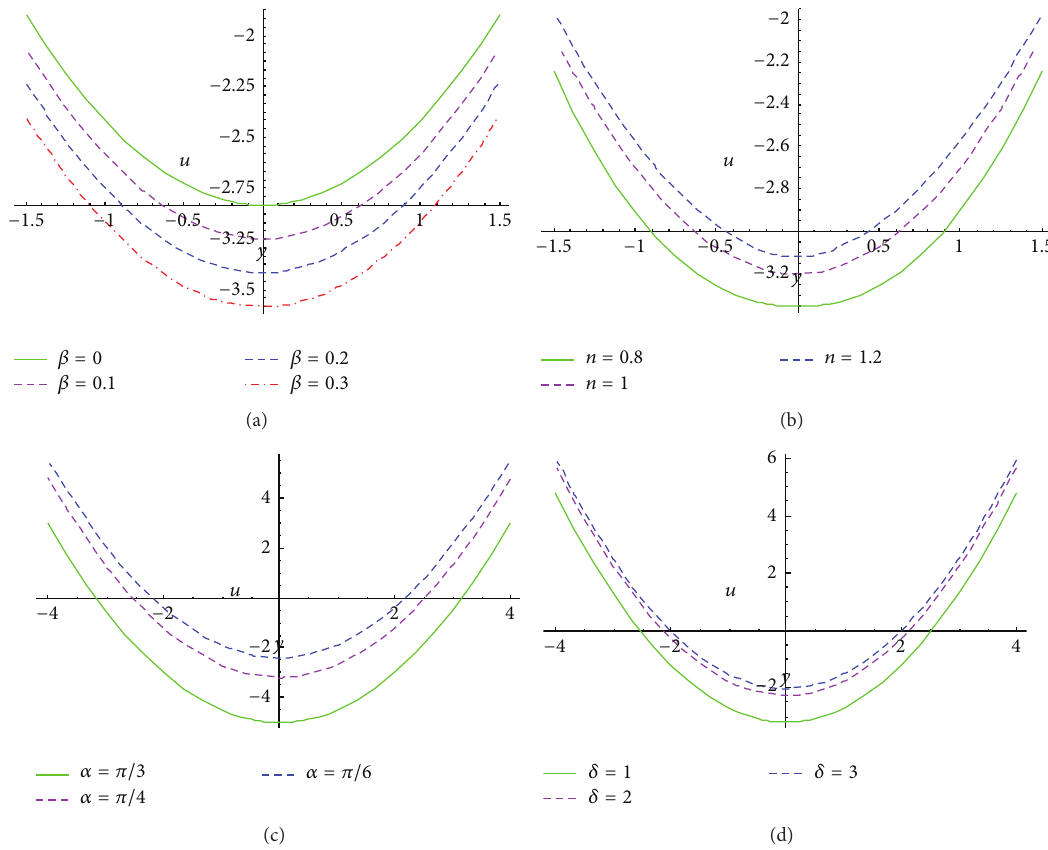
Figure 2: Velocity profiles (axial velocity versus transverse displacement) at 𝜙 = 0 . 5, 𝜕𝑝/𝜕𝑥 = 1, 𝑥 = 1 for (a) 𝑛 = 1, 𝛼 = 𝜋/ 4, 𝛿 = 1, and various values of slip parameter 𝛽 = 0 , 0 . 1 , 0 . 2 , 0 . 3, (b) 𝛽 = 0 . 1, 𝛼 = 𝜋/ 4, 𝛿 = 1, and various values of fluid behavior index 𝑛 = 0 . 8 , 1 , 1 . 2, (c) 𝛽 = 0 . 1, 𝑛 = 1, 𝛿 = 1, and various values of inclination of channel 𝛼 = 𝜋/ 3 , 𝜋/ 4 , 𝜋/ 6, and (d) 𝛽 = 0 . 1, 𝑛 = 1, 𝛼 = 𝜋/ 4, and various values of wave number 𝛿 = 1 , 2 ,